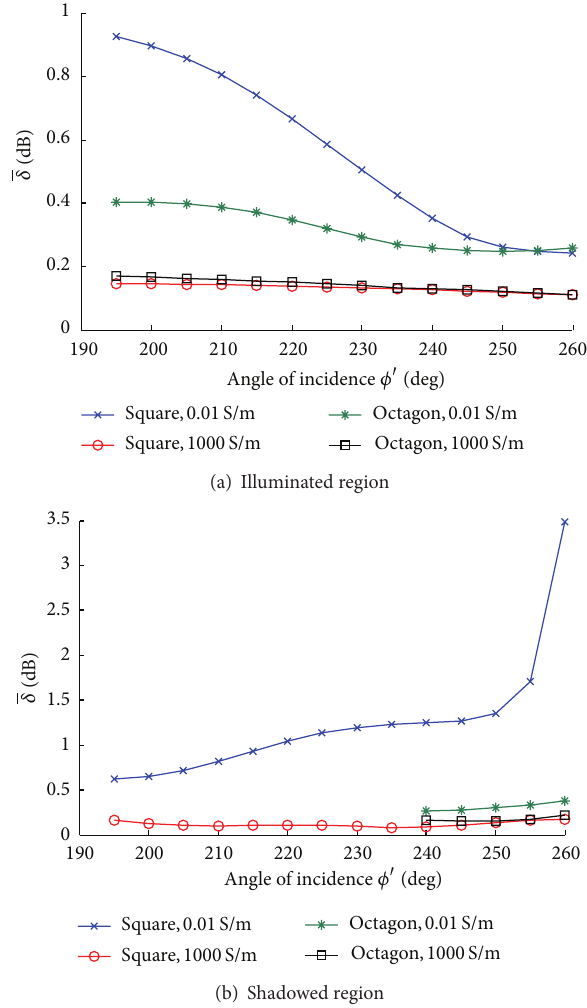
Figure 3: Average error between MOM EBC and MOM IBC for different shapes and